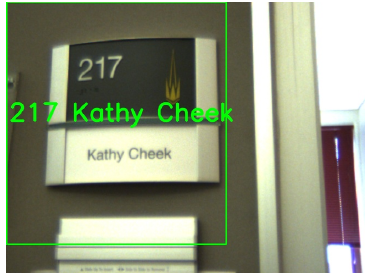
Figure 2: This sign is recognized and a measurement is made in the mapper. GoogleGoggles has read both the room number and the text, so this sign can be used for data